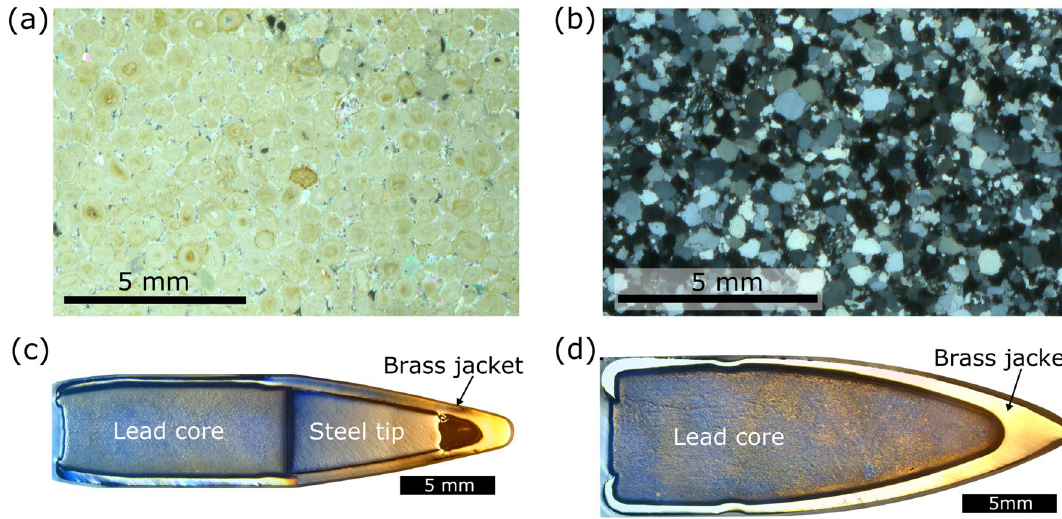
Figure 1. ( a ) Cross polarised photomicrograph of Cotswold Hill Cream Limestone. ( b ) Cross polarised photomicrograph of Stoneraise Red Sandstone. ( c ) Reflected light image of a cross section through a 5.56x 45 mm NATO projectile. ( d ) Reflected light image of a cross section through a 7.62x 39 mm projectile. (From 15